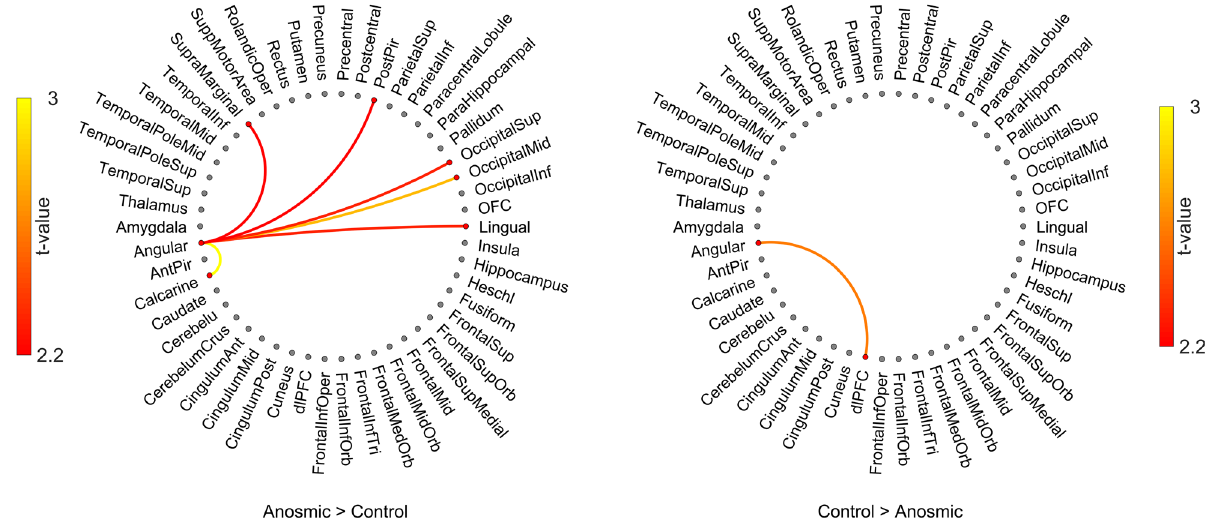
Figure 3. Dynamic functional connectivity from angular gyrus. Dynamic functional connectivity from the angular gyrus to other cerebral regions of interest with significant differences between groups marked with lines. Color of lines represents t -value according to color scale next to each plot. Left side plot shows where individuals with anosmia have stronger inter-regional connectivity and right-side plot shows where healthy control individuals have stronger inter-regional connectivity. Only differences with p < .05 are shown. Image created using Matlab (www. matwo rks. com) and Photoshop (www. adobe.